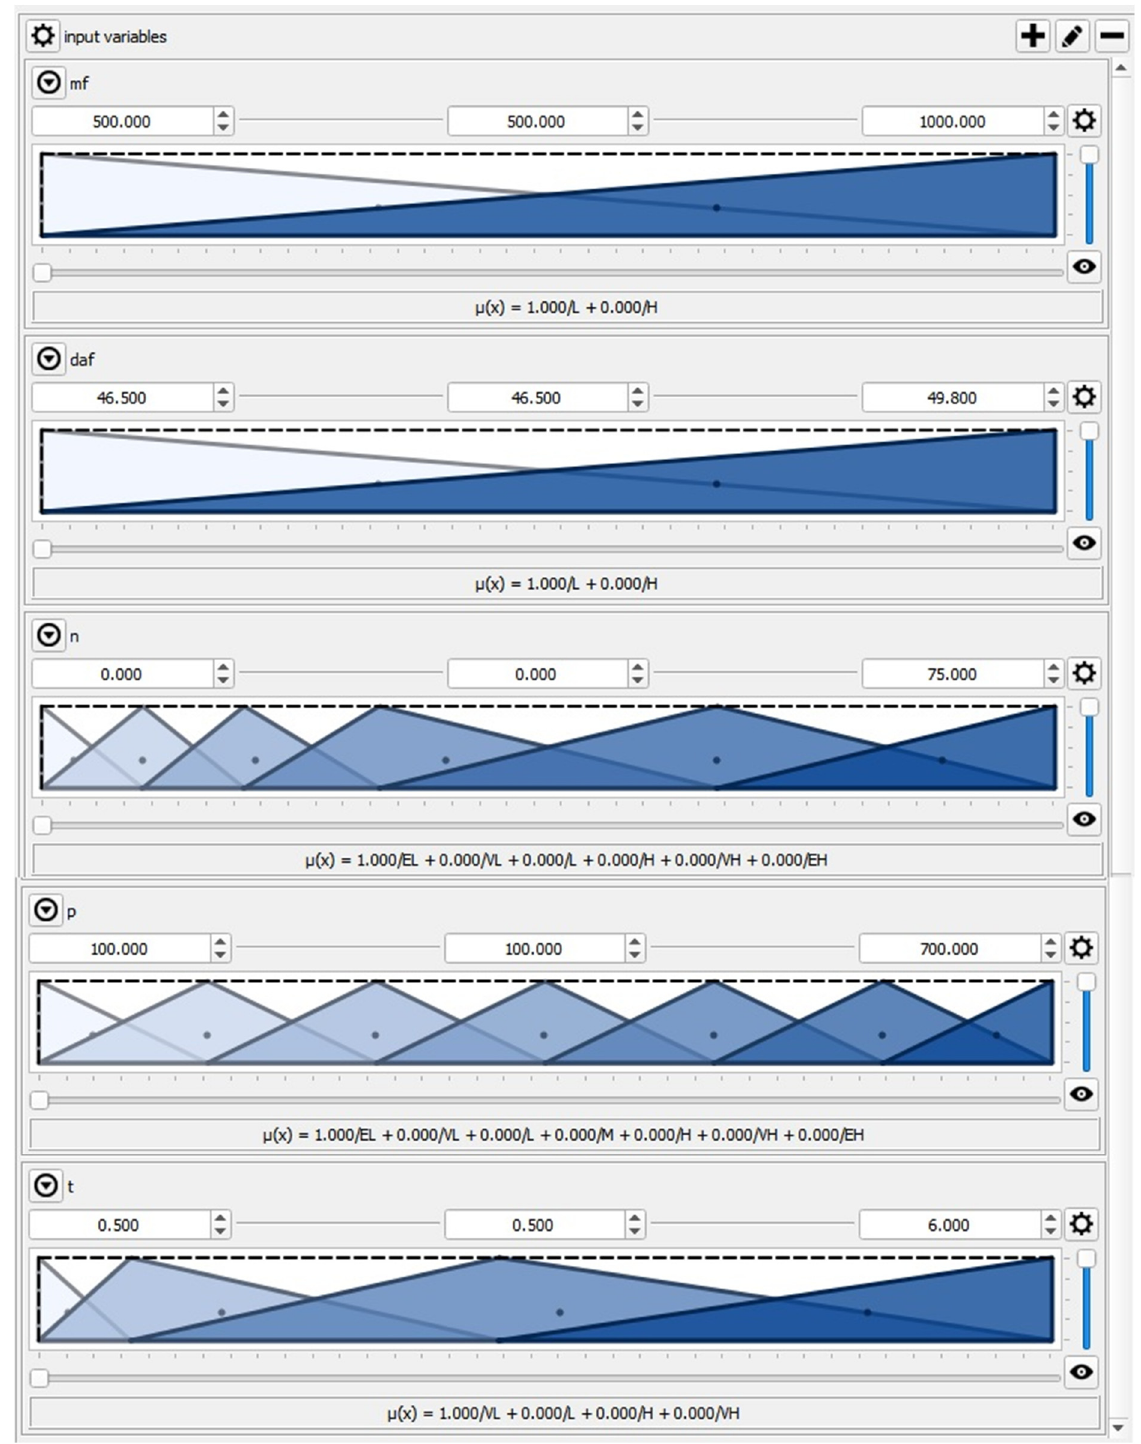
Figure 3. Membership functions for input variables: m f , d af , n, p, t (x-axes and y-axes correspond to parameter values from Table 4 and values of membership function, respectively).